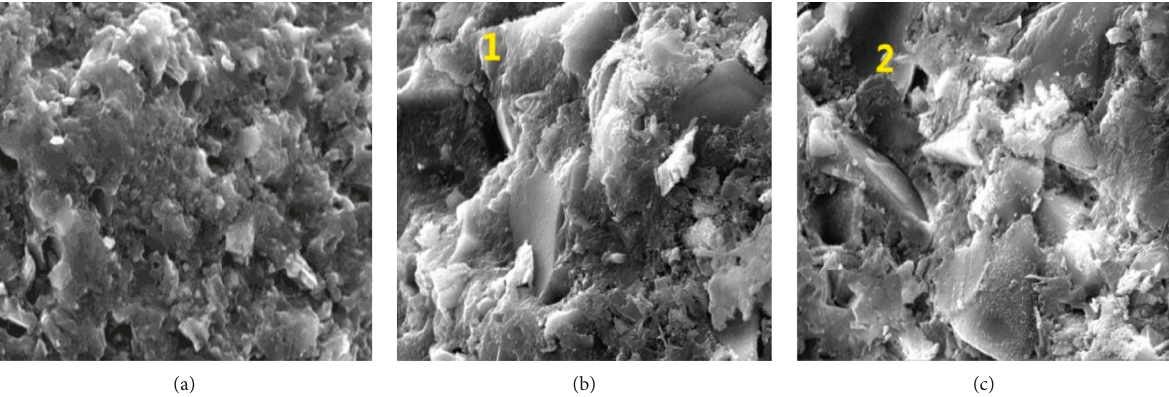
Figure 5: SEM images of C30 concrete: (a) A1, (b) A3, and (c) A5.